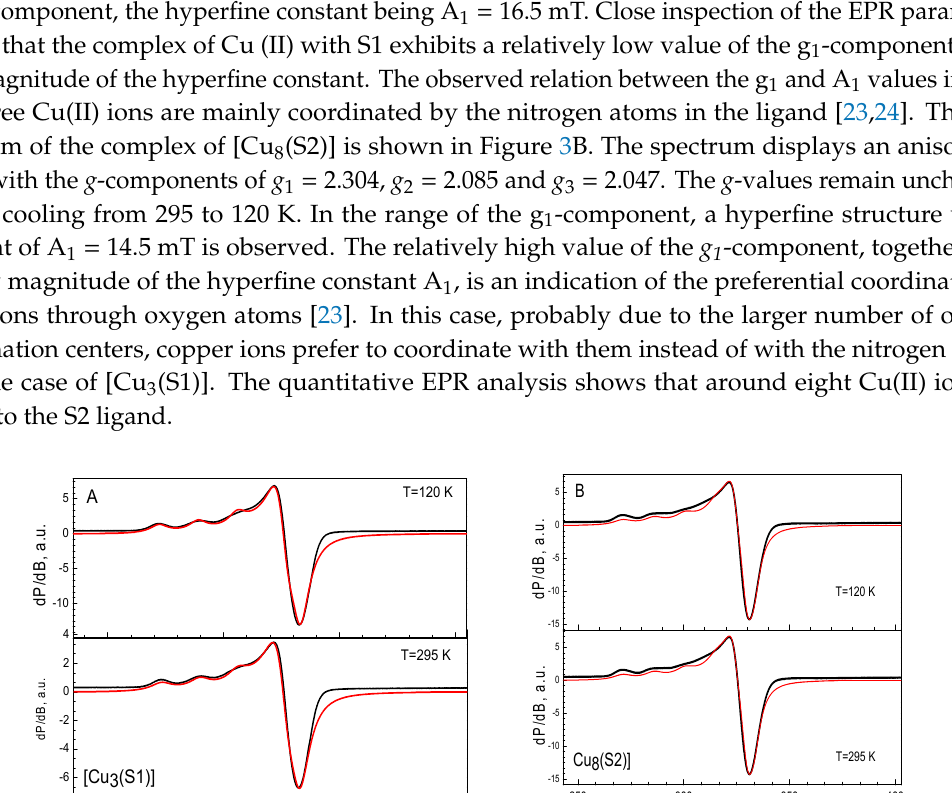
Figure 3. EPR spectra of [Cu 3 (S1)] ( a ) and [Cu 8 (S2)] ( b ) complexes. The black and red lines correspond to the experimental and simulated spectra, respectively.